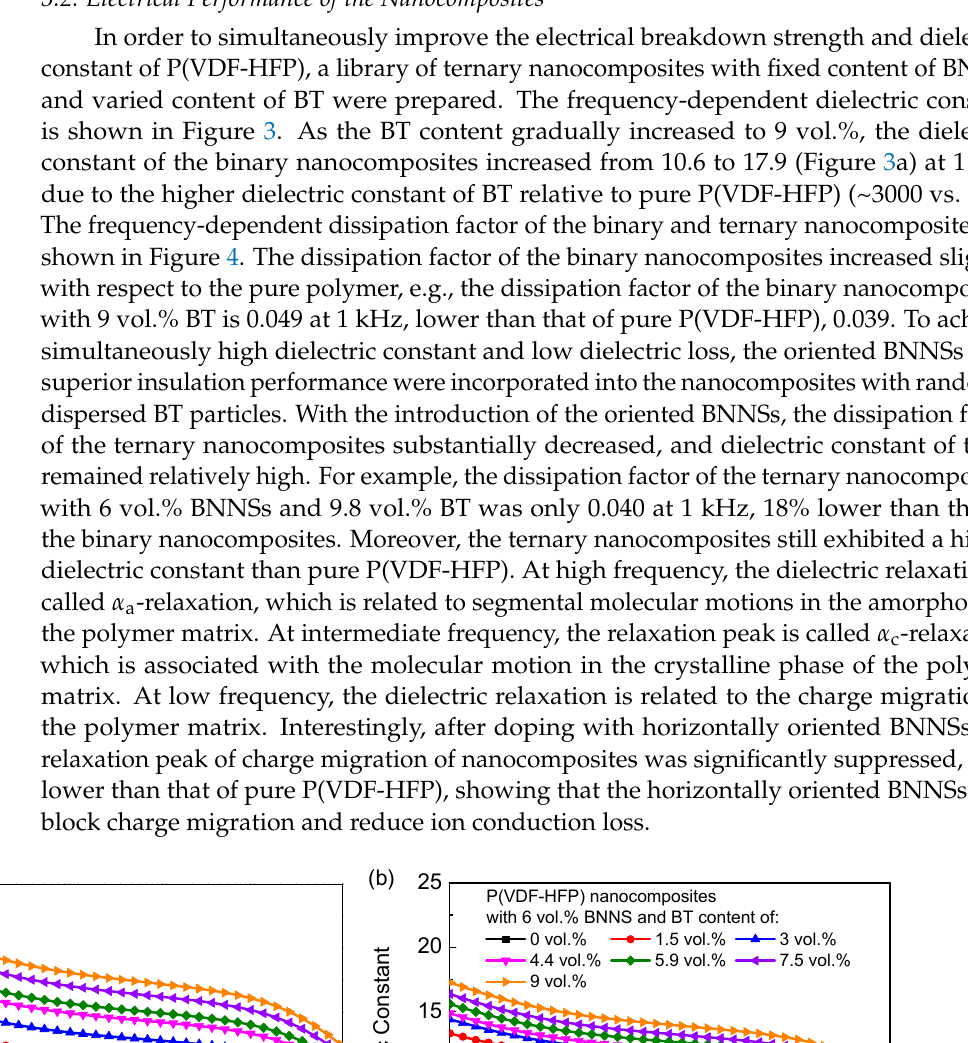
−− − Figure 4. Frequency-dependent dissipation factor of ( a ) the P(VDF-HFP)/BT nanocomposites and ( b ) the ternary nanocomposites with 6 vol.% BNNSs. The dissipation factor only represents the dielectric loss under low electric fields, but the capacitor films usually operate under high electric fields. Figure 5a shows the leakage currents of pure P(VDF-HFP), binary nanocomposites, and ternary nanocomposites under an electric field of 100 MV/m. It is clear that the introduction of BT resulted in a significant increase of leakage current in the binary nanocomposites; i.e., the leakage current density increased from 4.6 × 10 − 7 A/cm 2 for pure P(VDF-HFP) to 8.1 × 10 − 6 A/cm 2 for the binary nanocomposites, which is nearly one order of magnitude higher. Conversely, the introduction of oriented BNNSs could effectively suppress the leakage current. The leakage current of the ternary nanocomposites (i.e., 7.3 × 10 − 8 A/cm 2 ) is two orders of magnitude lower than that of the binary nanocomposites. It is also even much lower than that of the pure P(VDF-HFP). Therefore, the oriented BNNSs not only suppress the dielectric loss under low electric fields but also reduce the leakage current under high electric fields in P(VDF-HFP) nanocomposites. Apart from high dielectric constant and low conduction loss, high electrical breakdown strength of polymer dielectrics is highly desired to pursue high energy density. The electrical breakdown strength of the binary nanocomposites and the ternary